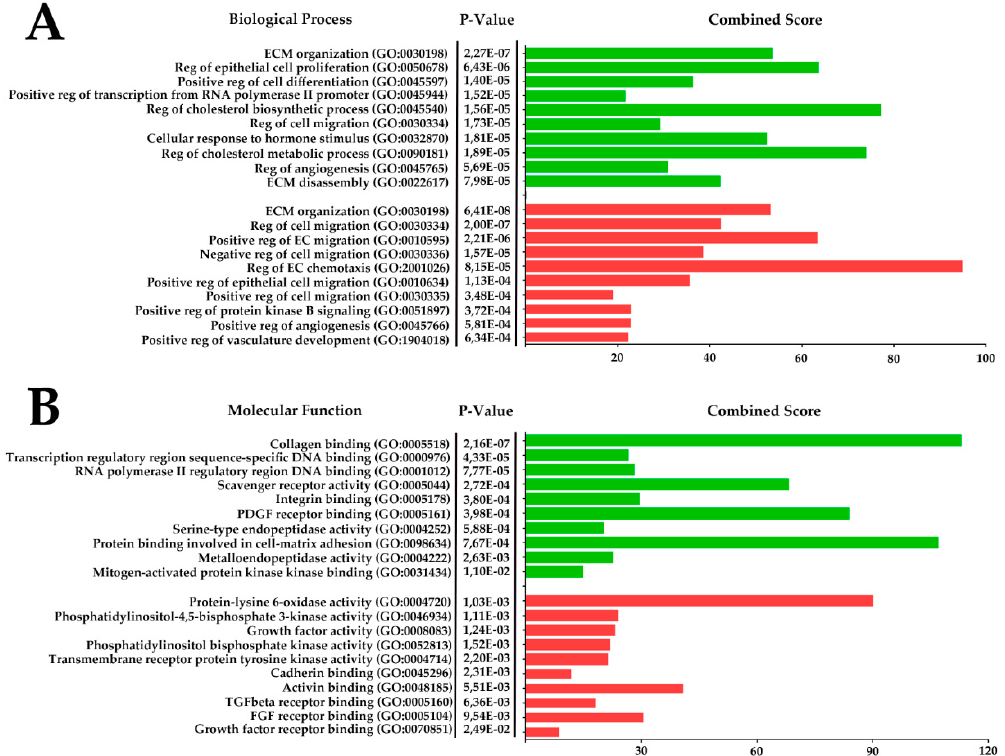
Figure 7. Presentation of RNA-sequencing results mapped using Gene Ontology biological process ( A ) and molecular function ( B ). Data from libraries obtained after RNA-sequencing of monolayer MSC and MSC-based CS were normalized and upregulated (green) and downregulated (red) transcripts were mapped using Gene Ontology. The top 10 p -value clusters with a minimum of 3 overlaps after GO mapping were supplemented by combined score calculation (Enrichr). Reg—regulation; ECM—extracellular matrix; EC—endothelial cells; SMC—smooth muscle cell.